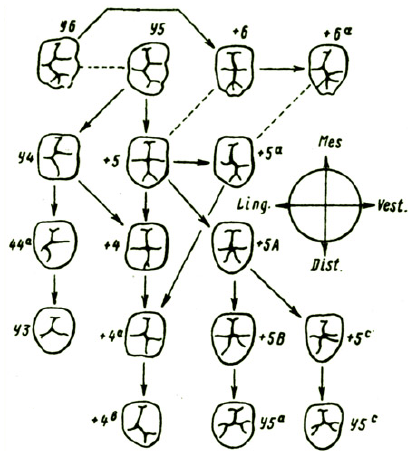
Figure 6. Tooth type classification